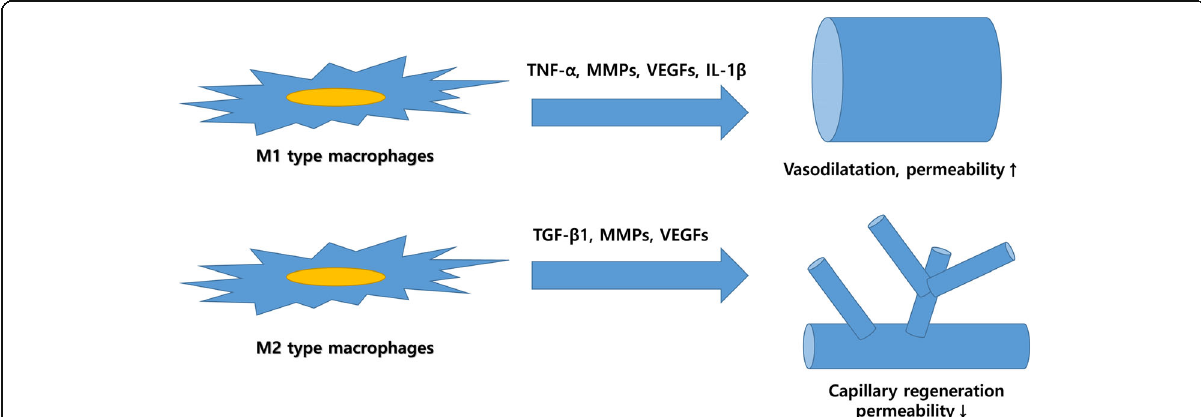
Fig. 2 Role of M1/M2-type macrophages in angiogenesis. M1-type macrophages are responsible for host defenses again invasion. Thus, cytokines secreted from M1-type macrophages recruit leukocytes through vasodilatation and increasing vascular permeability. However, M2-type macrophages are responsible for regeneration. Accordingly, they secrete cytokines for capillary regeneration. Some cytokines are overlapped between M1 and M2 macrophages, and their final role is determined by the interaction with other